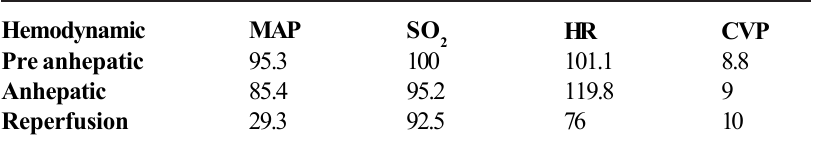
TABLE 3 - Clinical parameters in the recipients Hemodynamic